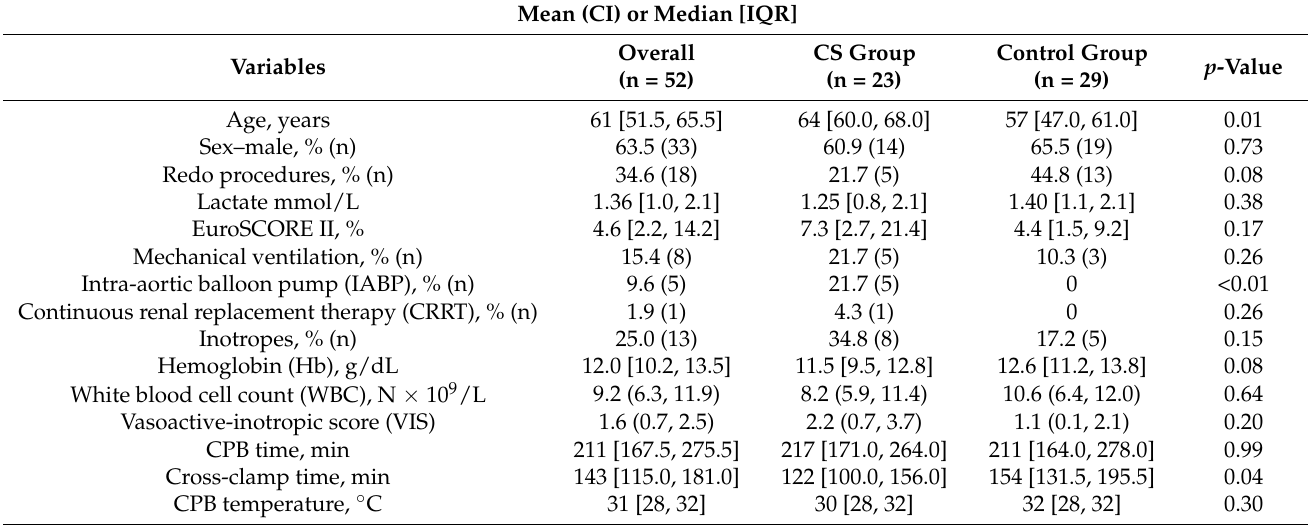
Table 1. Baseline characteristics.